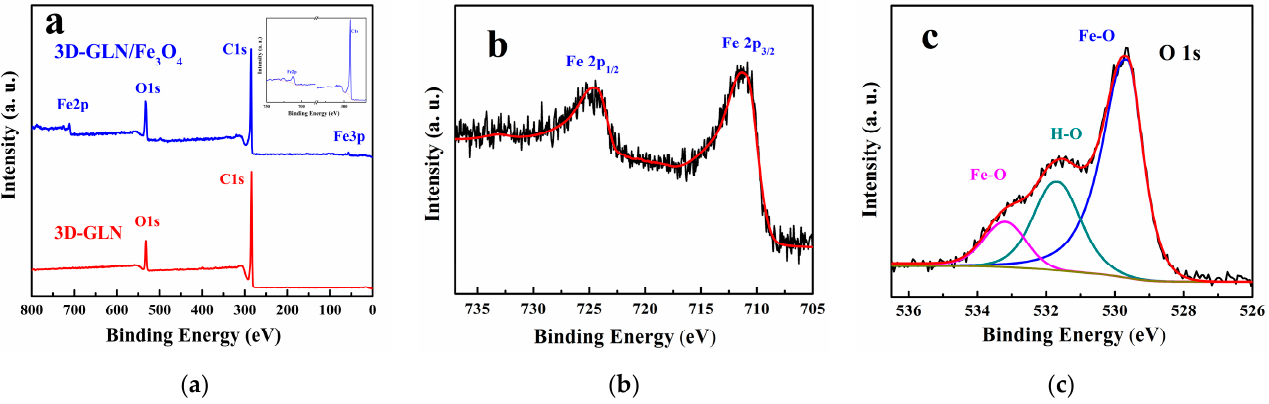
Figure 5. XPS survey spectra of 3D-GLN and 3D-GLN/Fe 3 O 4 ( a ). The Fe2p ( b ), and O1s ( c ) XPS spectra of 3D-GLN/Fe 3 O 4 .